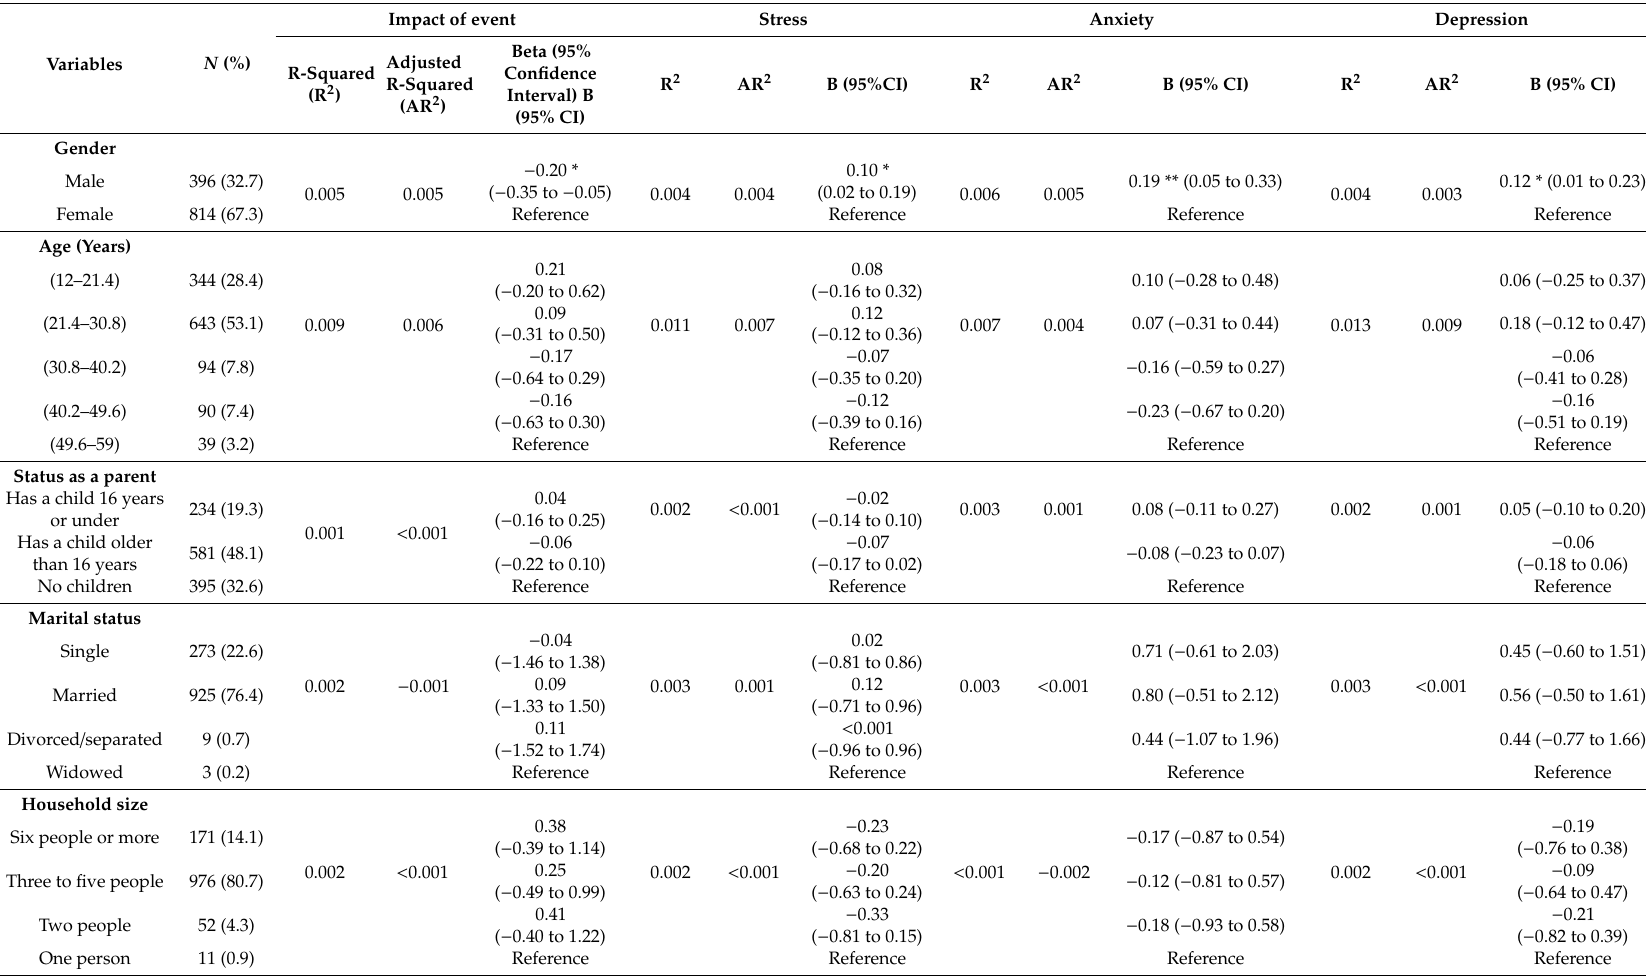
Table 1. Association between demographic variables and the psychological impact of the 2019 coronavirus disease (COVID-19) outbreak as well as adverse mental health status during the epidemic ( n =